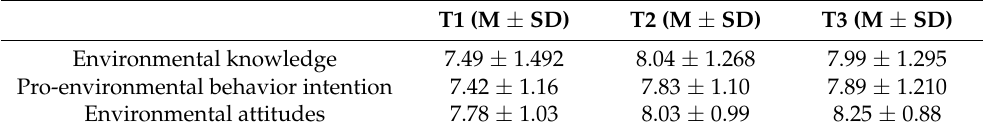
Table 4. Descriptive statistics of various indicators of children’s environmental